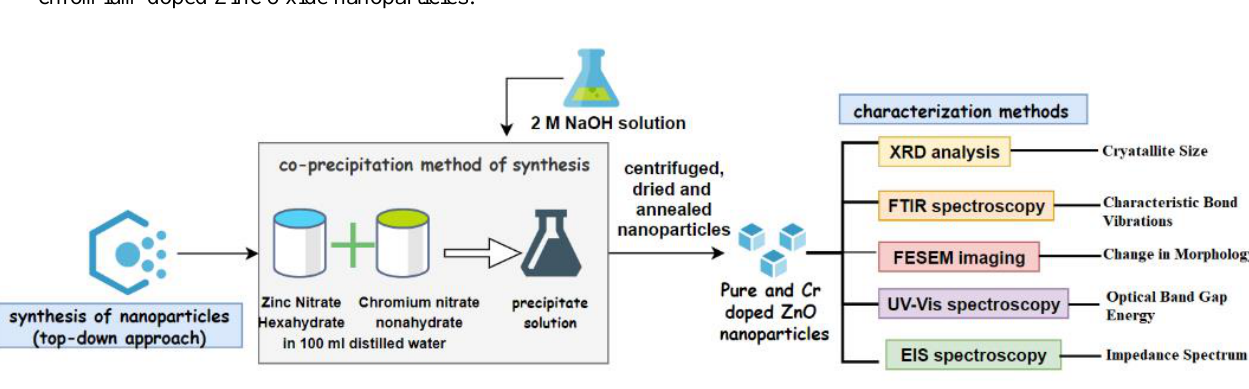
Figure 1. Schematic representation of synthesis of pure and Cr and ZnO nanoparticles.